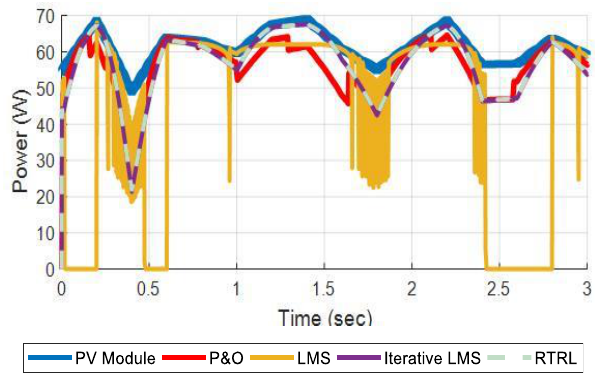
Figure 15. Results of the P&O, LMS, and RTRL controllers under conditions of variable temperature and constant irradiance.